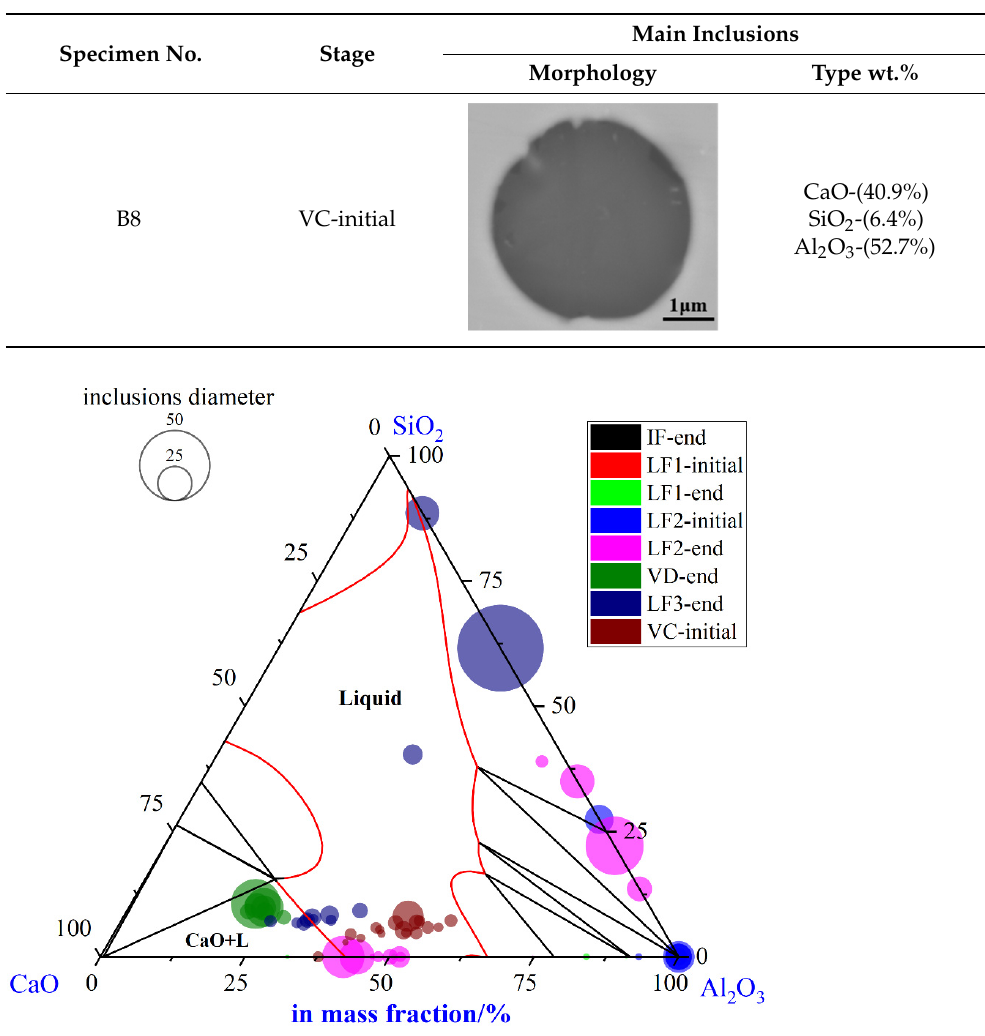
Figure 9. Composition and size distribution of large-size inclusions during the optimized metallurgical process in CaO-SiO 2 -Al 2 O 3 ternary phase diagram at 1873 K.